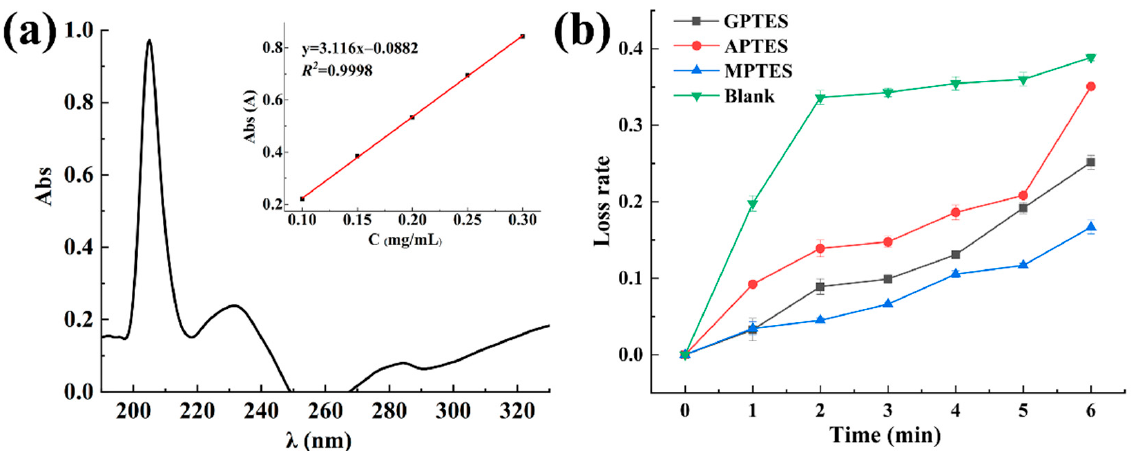
Figure 6. ( a ) Standard curve for LFO; ( b ) UV curves of fragrance content of modified EC/SiO 2 fragrance microcapsules and EC fragrance microcapsules treated at 120 °C.